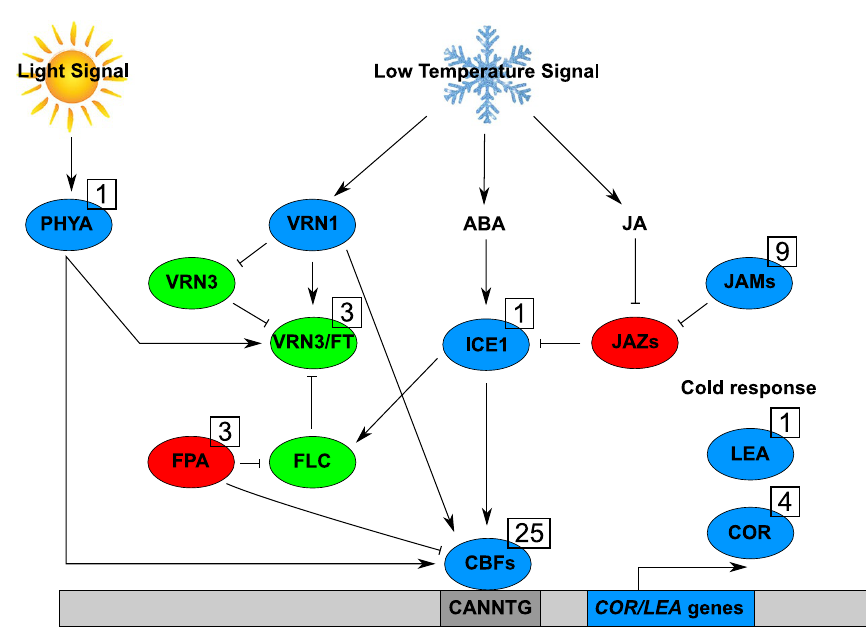
Figure 2. Cold response regulatory pathway based on identified genes for FroT in the current study: The major key transcription factor ICE1 becomes initiated via low temperature signals and ABA, repressed via JAZ proteins and control transcription of CBF genes. CBFs regulate the expression FroT response genes ( COR/LEA genes). On the other site vernalization genes regulate flowering and specially VRN1 is involved in FroT response. FPA promotes flowering and represses FroT. PHYA which are regulated via light signals promotes flowering and also FroT. Ovals represents proteins and the bar on the bottom genomic DNA. The blue color indicated positive FroT regulators, red repressors and green flowering proteins. The gray box (CANNTG) in the bar on the bottom stays for CBF promotor interaction sequence. The arrows symbolize activation and T headed lines repression. The numbers in black boxes representing the count of identified genes in the current study. PHYA Phytrochrome A, VRN Vernalization, FLC Flowering Locus C, FT Flowering Locus T, FPA Flowering time control protein, ABA Abscisic acid, ICE inducer of CBF expression, CBF C-repeat binding factor, JA Jasmonate, JAZ Jasmonate zim domain, JAM Jasmonate associated MYC2-like, LEA Late embryogenesis-abundant and COR